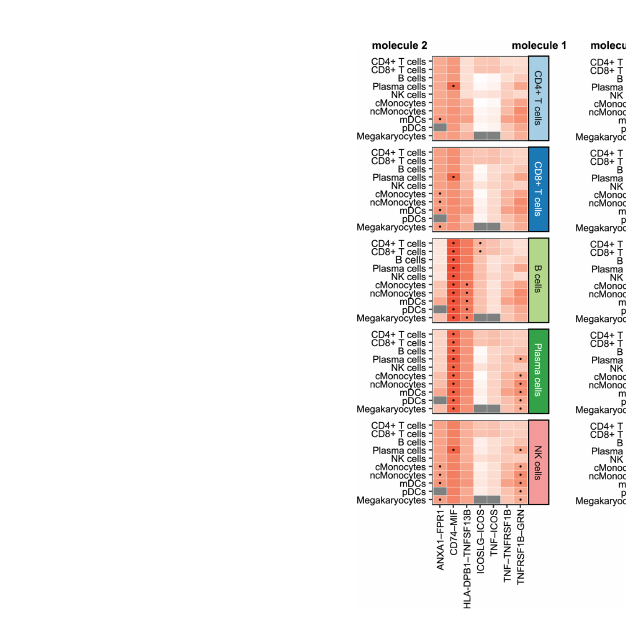
FIGURE 6 | Cellular communication: potential interactions of DEGs in cells of CeD cases after diagnosis. Overview of selected ligand – receptor interactions determined using CellPhoneDB on the cells of CeD cases after seroconversion (T1). Horizontal axis shows the pairs of interacting molecule 1 and interacting molecule 2. Vertical axis indicates the cell types with identi fi ed interacting molecules: on the left are the cell types with the identi fi ed molecule 2, whereas cell types with the identi fi ed molecule 1 is on the right. The log2-transformed mean expression of interacting molecule 1 and interacting molecule 2 are indicated by color. Signi fi cant results (p-value < 0.05) are indicated with a dot. Grey color indicates NA results, usually occurring in cell types with few